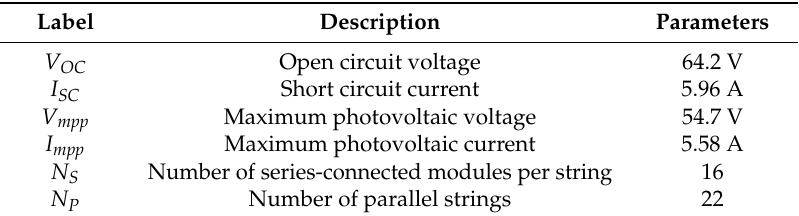
Table 2. PV module specifications (STC) and modules arrangement.